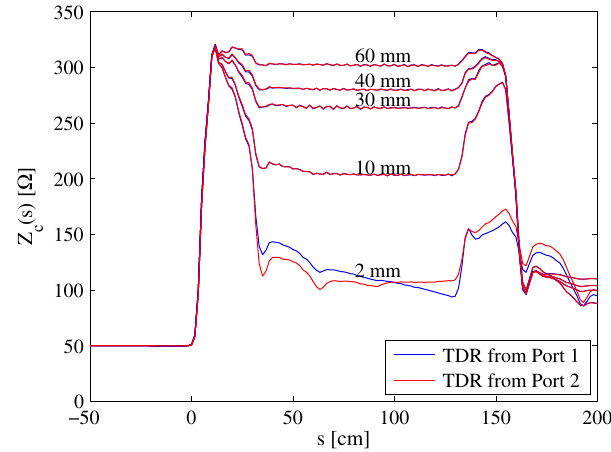
FIG. 12. TDR measurements from the two ports of the collimator for different values of the full jaws gap. The double BPM tapering and longitudinal rf finger transitions to the jaws are visible. Moving the jaws toward smaller values of full gap the characteristic transmission line impedance Z c is